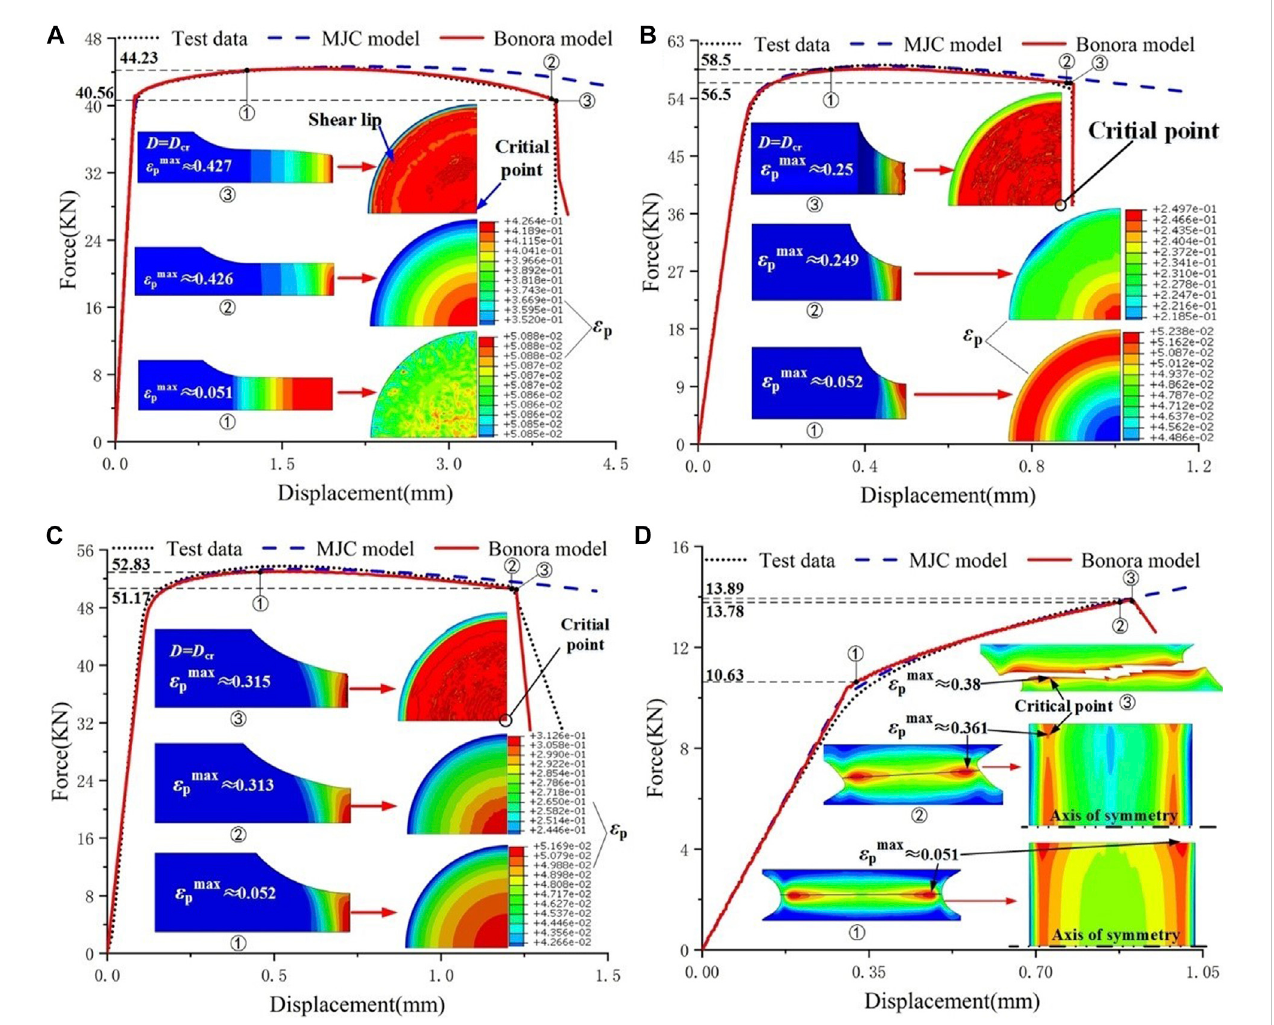
FIGURE 5 Load versus displacement curves obtained in the tests and FEA simulation: (A) the smooth round bar ( (cid:1) ε cr = 0.427, α = 0.023); (B) the notched round bar, R = 5 mm ( (cid:1) ε cr = 0.25, α = 0.005); (C) the notched round bar, R = 10 mm ( (cid:1) ε cr = 0.315, α = 0.01); (D) shear-induced specimen ( (cid:1) ε cr = 0.38, α = 0.001).